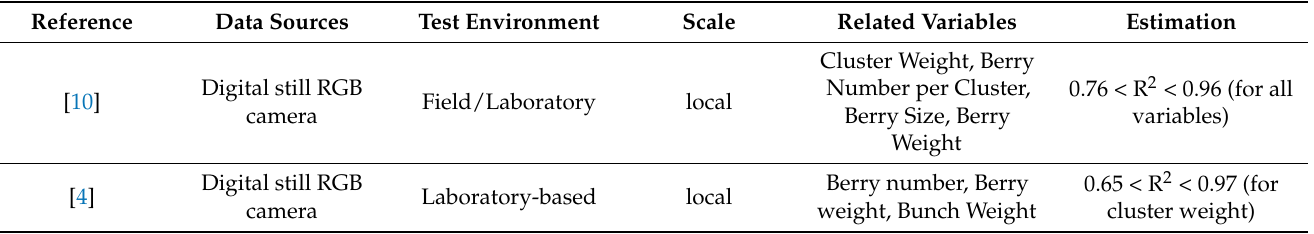
Table 2. Summary of records included in the systematic review (data-driven Models based on computer vision and image